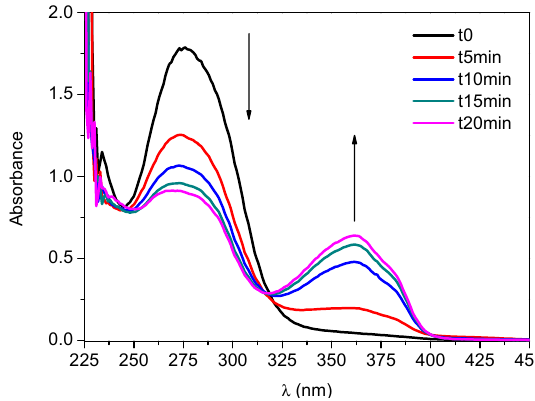
Figure 2. Steady-state photolysis of the AB-DCF ethanolic solution (4.3 × 10 − 5 M) by means of simulated sunlight (SSL) under N 2 ( A ) and air ( B ) atmospheres followed by UV-Vis spectrophotometry.